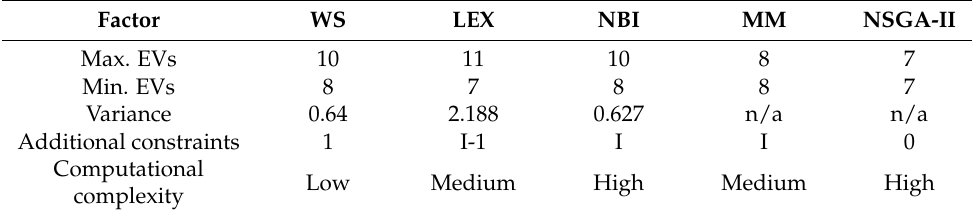
Table 5. Comparison of MOO